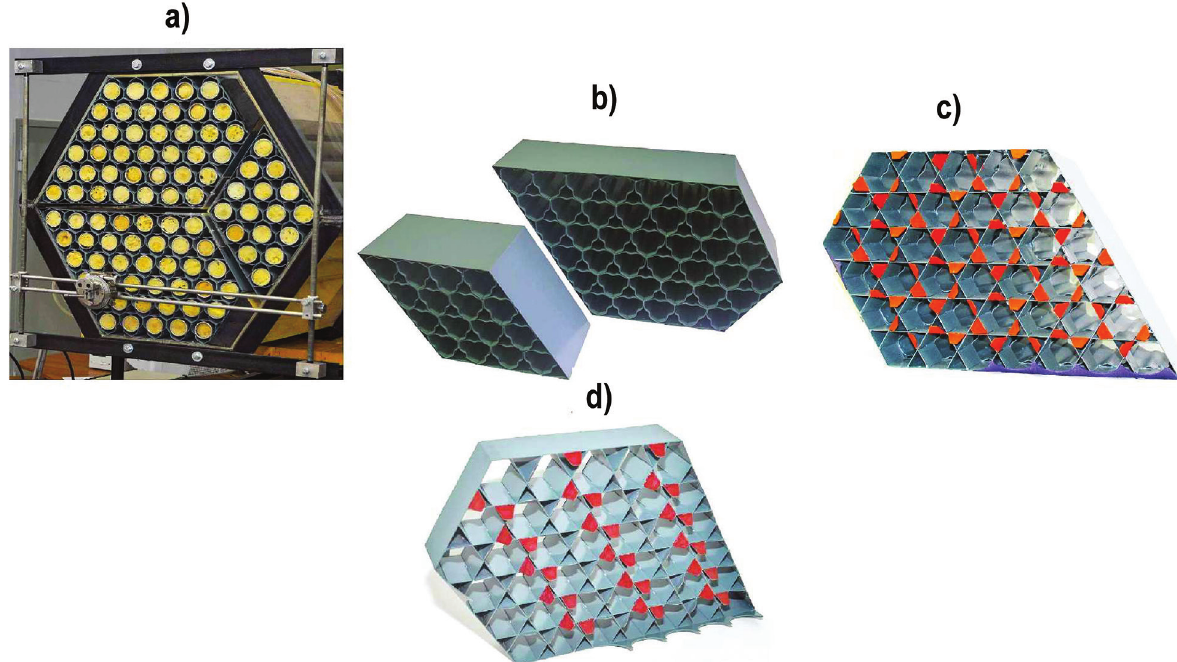
Figure 1. TMs and fuel assembly grid belts: a) VVER core portion TM; b) TVSA U and TVSA-T SG belt; c) TVSA-T CSG belt; d) TVSA U MG